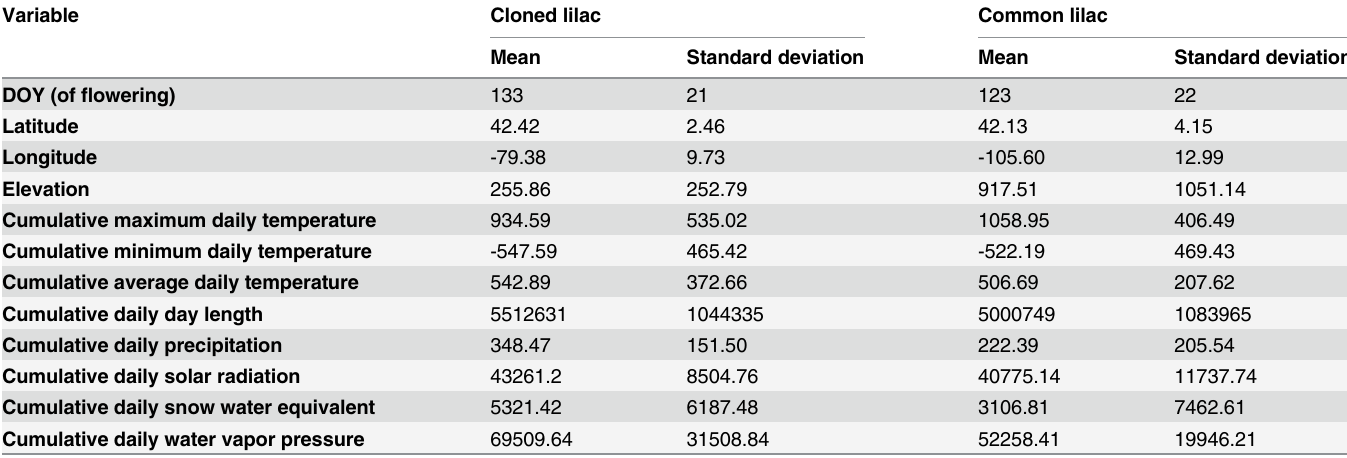
Table 1. Mean and standard deviation of the geographic and climatic parameters for cloned and common